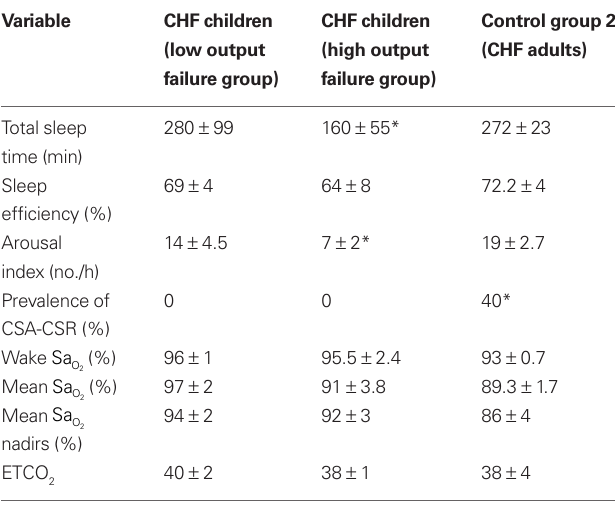
Table 4 | Baseline characteristics and polysomnographic characteristics of the CHF patients according to their